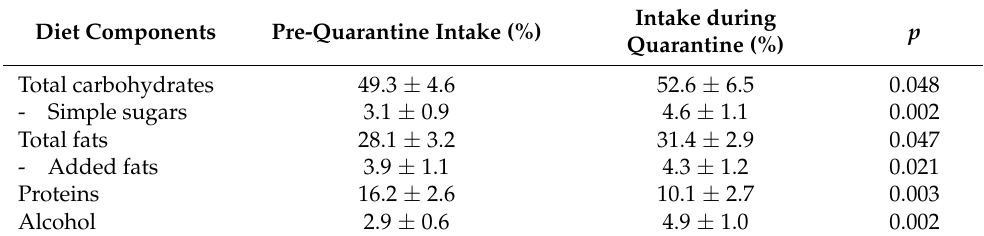
Table 2. Percentage of total energy derived from the main diet components of the interviewed